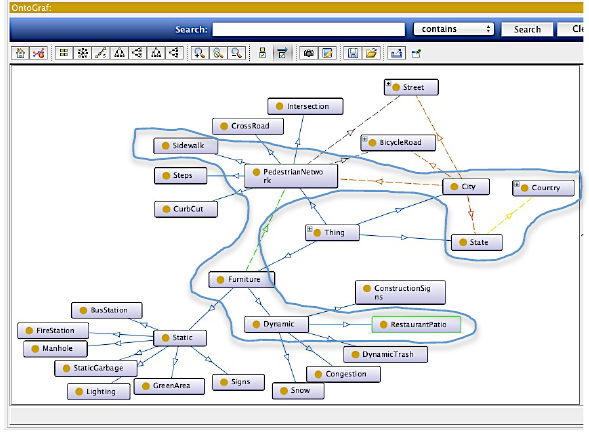
Figure 4. Nature-Development perspective